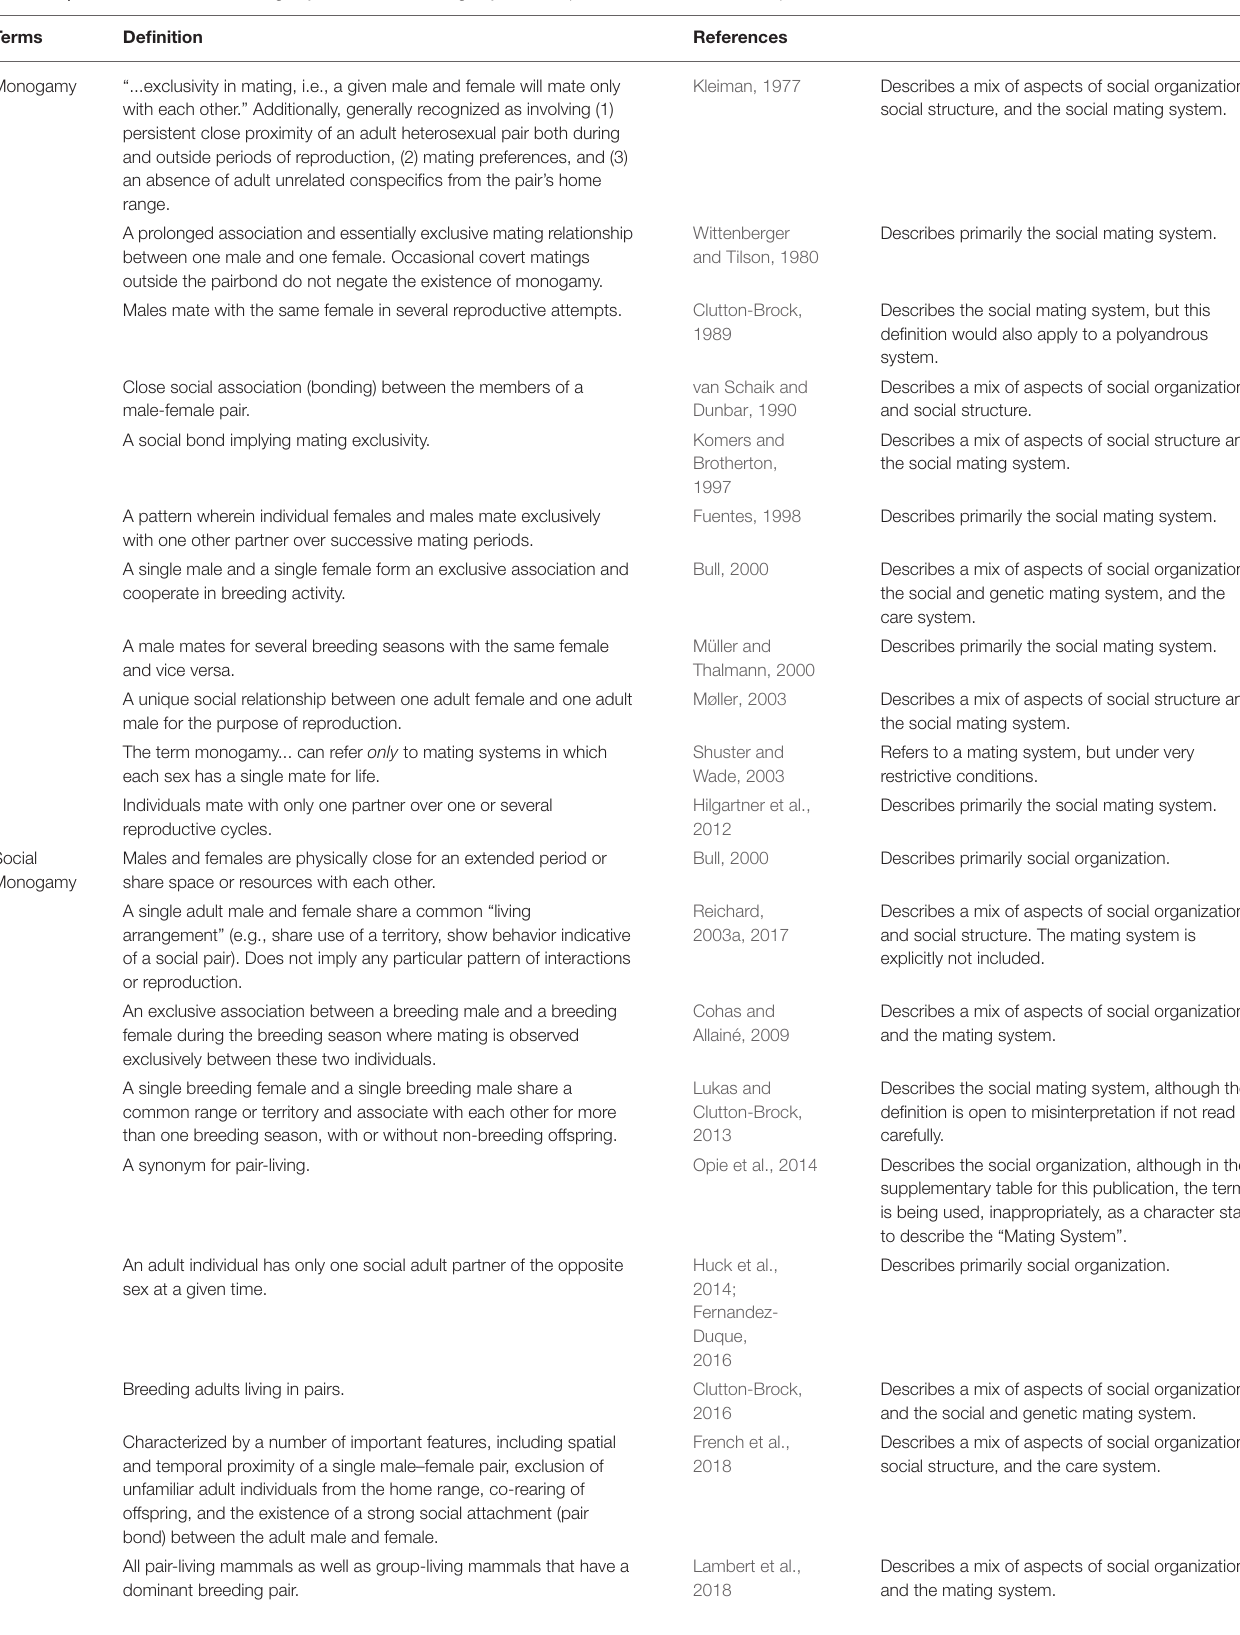
TABLE 1 | Some definitions of “monogamy” and “social monogamy” used in prior studies and reviews of primates and other